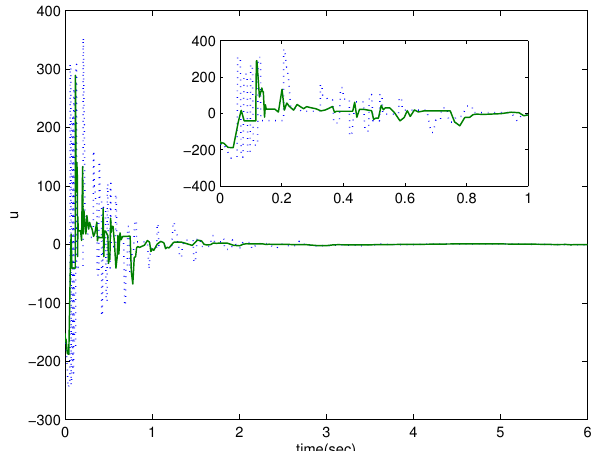
Figure 4. The control input evolution curves (the proposed method with solid lines, the memoryless design method with dashed